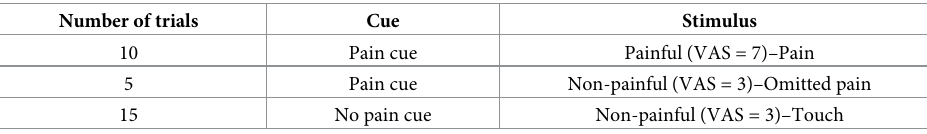
No pain cue Non-painful (VAS =